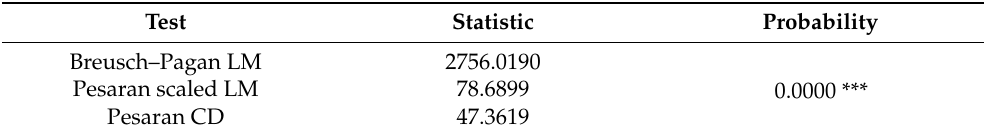
Table 2. Cross-sectional dependence test